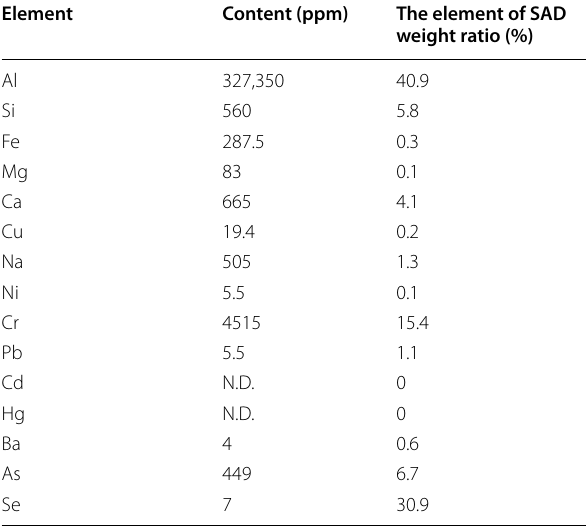
Table 2 pH drop of Na intermediate product